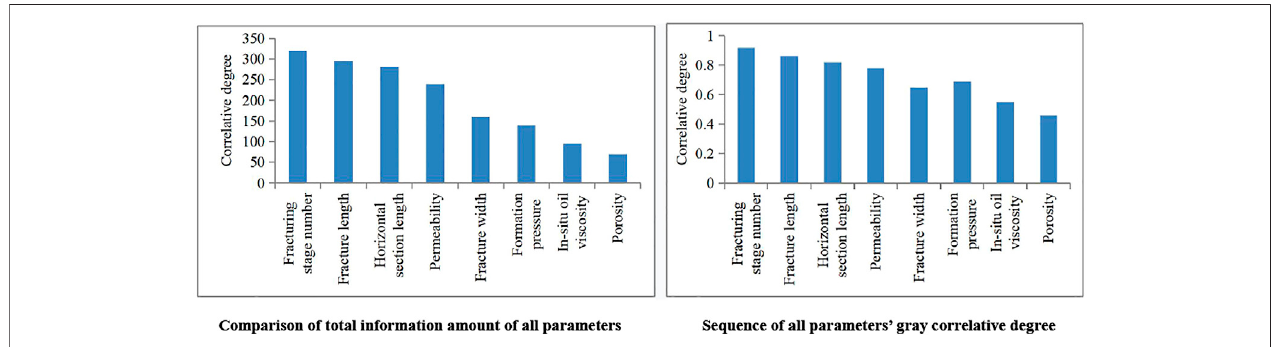
FIGURE 1 | Grey correlation analysis method for horizontal well productivity. Sources: Liang et al. (2013) and Luo et al. (2021).